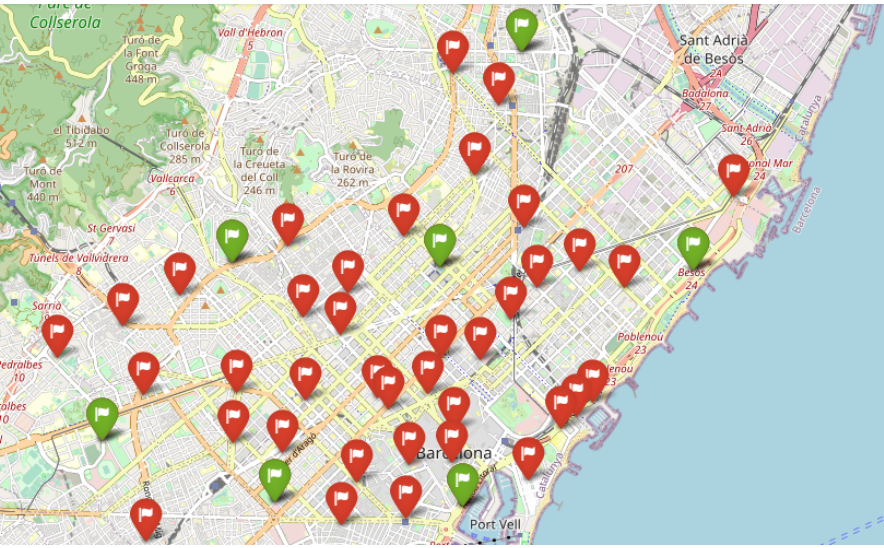
Figure 8. Very Fluid, 7 Selected Facilities.